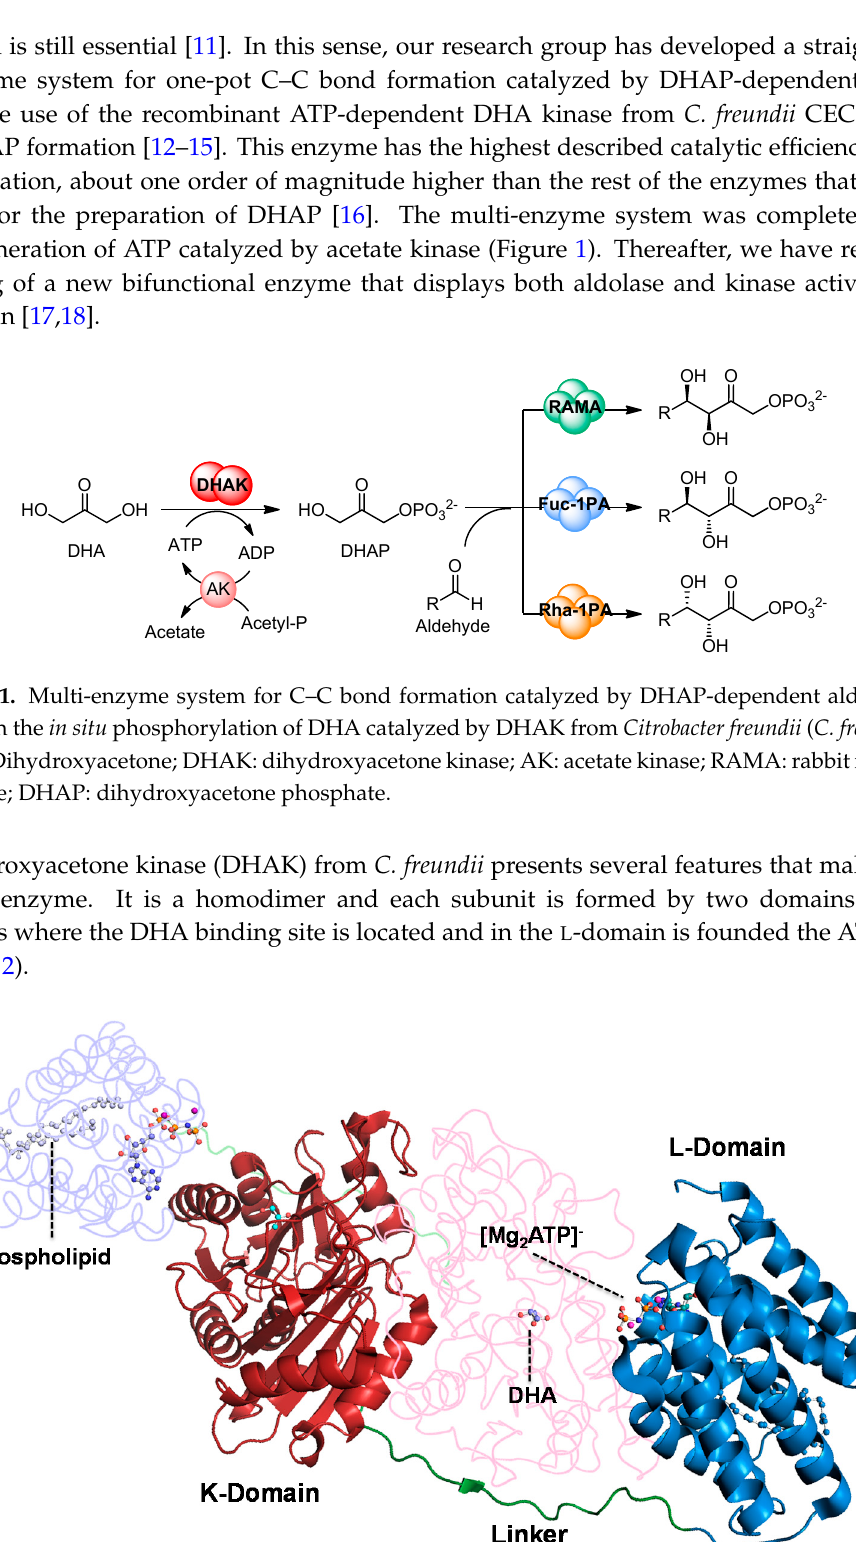
Figure 2. Crystallographic structure of DHAK from C. freundii strain DSM 30040 (pdb 1un9). In the N-terminal domain—K-domain—is where the DHA binding site is located. The ATP binding site is found in the C-terminal— L -domain.